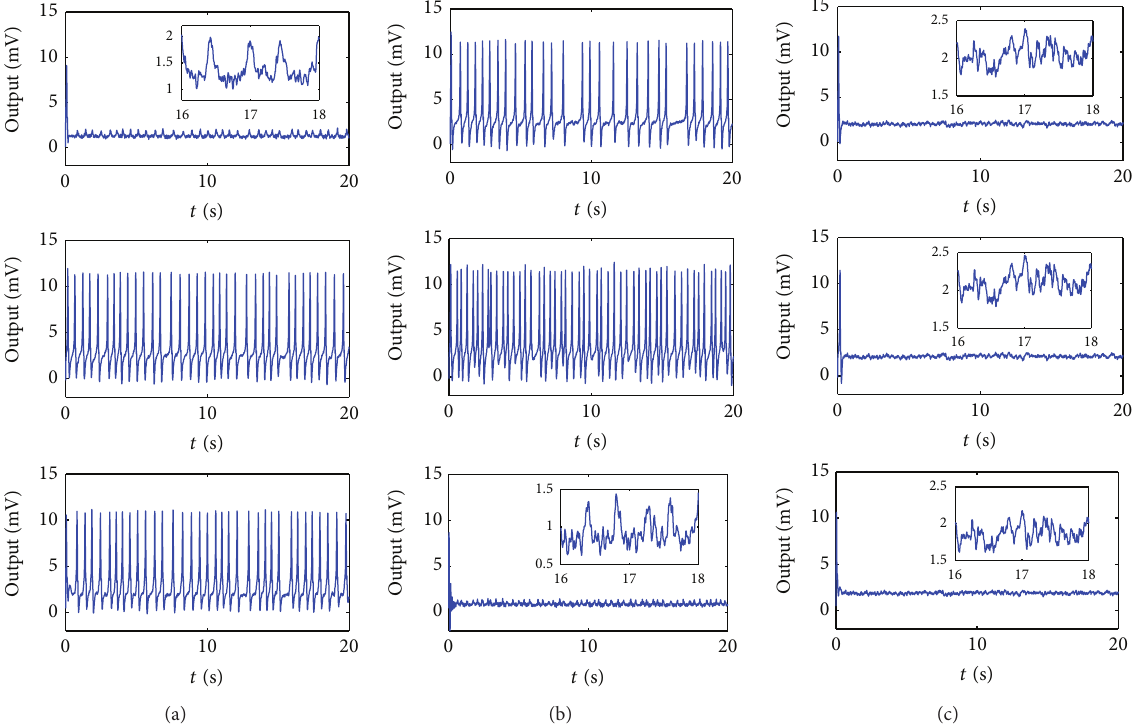
Figure 7: The output waveforms for the use of the proposed control to the model containing two hyperexcitable populations. (a) 𝑘 𝑝1 = 5.5 , = 𝑘 = 0 . (b) 𝑘 = 𝑘 = 0 , 𝑘 = 10 . (c) 𝑘 = 𝑘 = 0.86 , 𝑘 = 0 𝑘 𝑝2 𝑝3 𝑝1 𝑝2 𝑝3 𝑝1 𝑝2 𝑝3